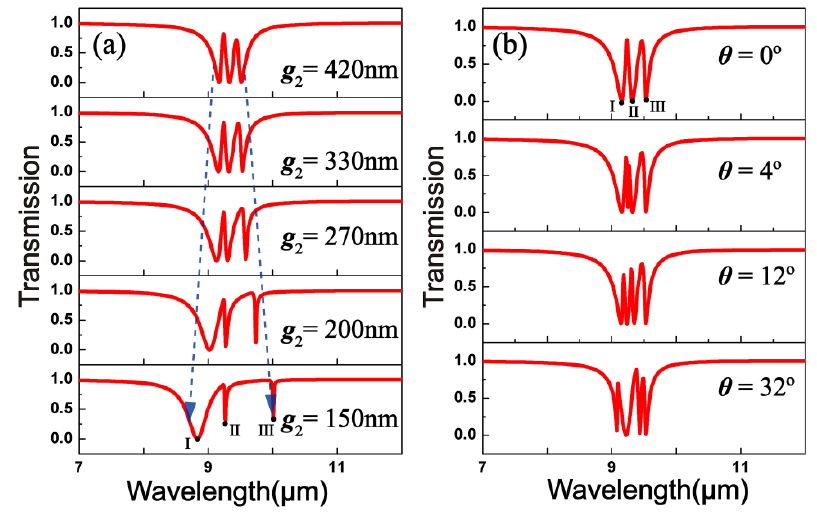
Figure 6. ( a ) Transmission spectra of structure II at diverse gap g 2 values between the first and the second layers of GNRs; ( b ) Spectral responses of structure II at different angles of incidence.